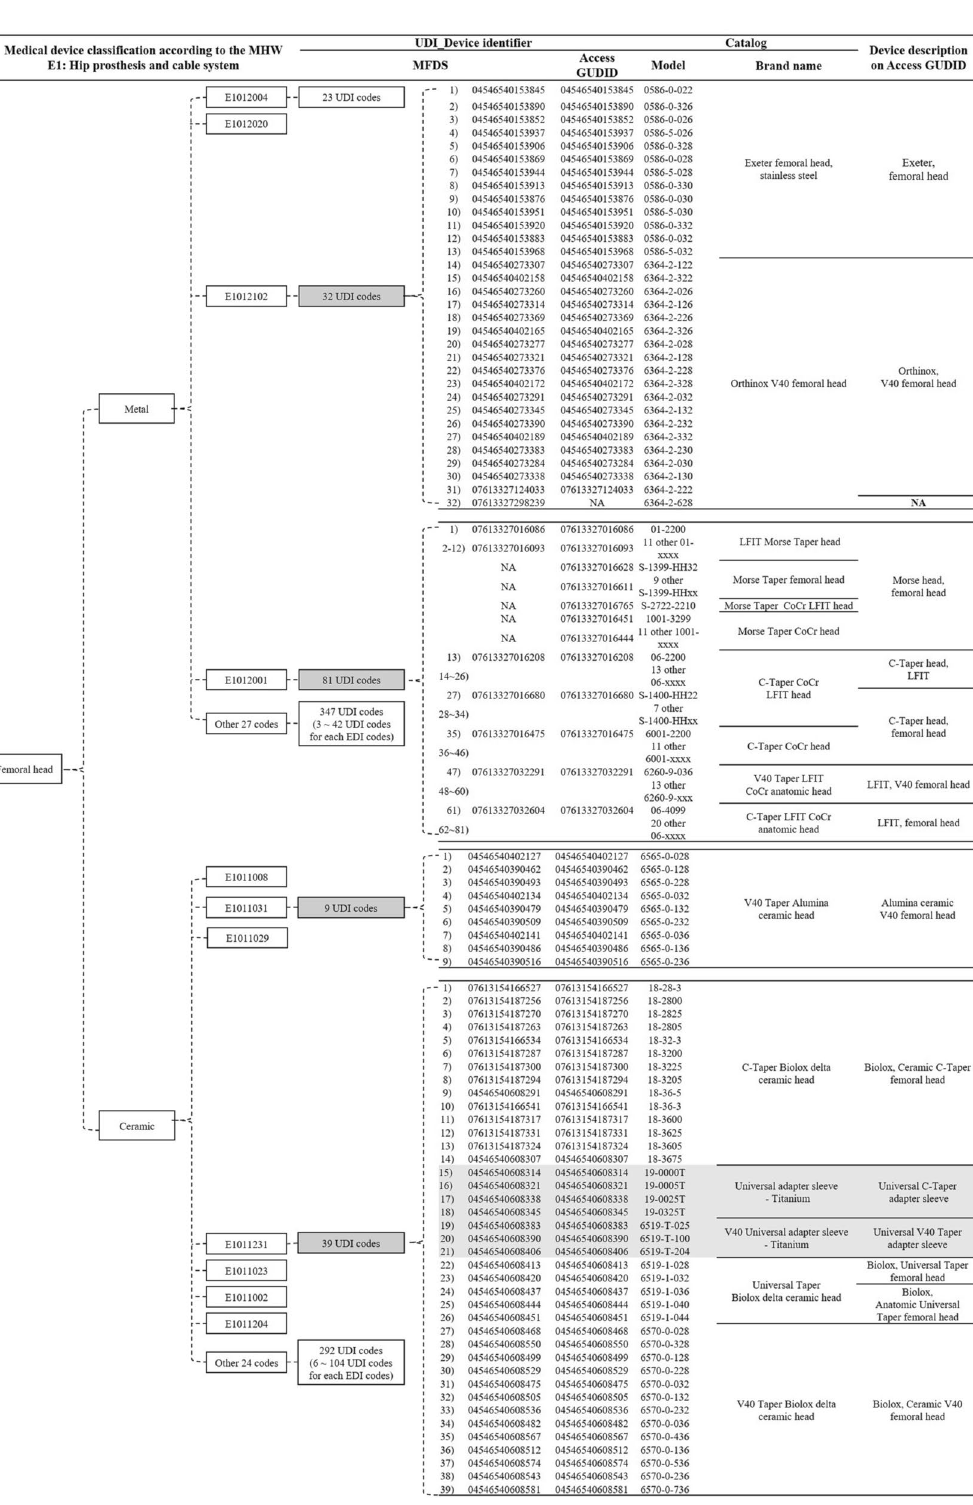
Figure 5. Analysis of various medical device data for the chemical head selected as a focus group. MHW Ministry of Health and Welfare, UDI unique device identifier, MFDS Ministry of Food and Drug Safety, GUDID global unique device identification